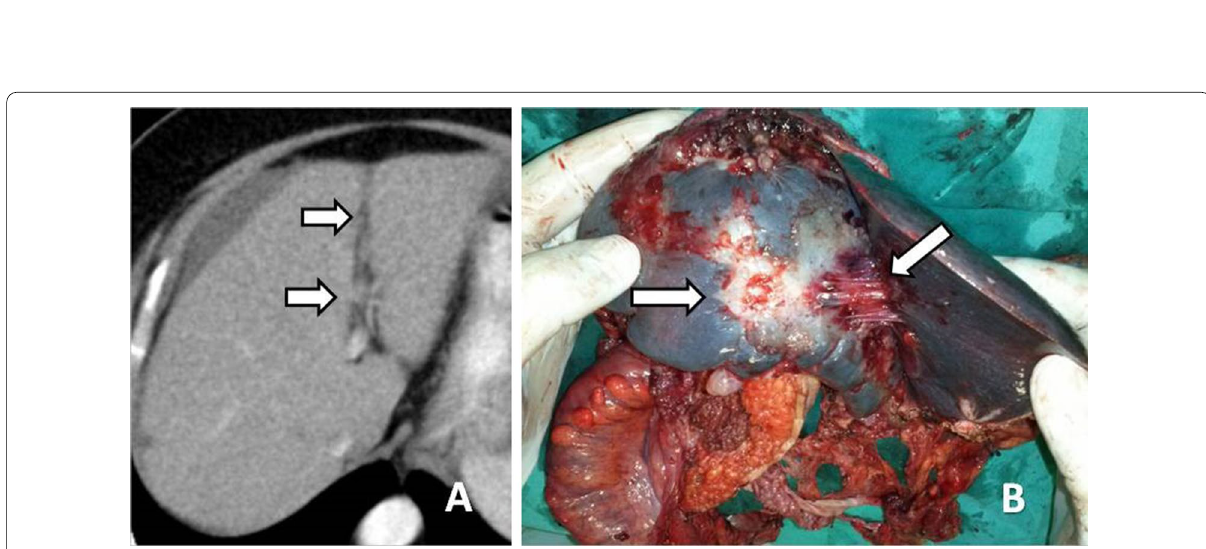
Fig. 6 Patient with ovarian cancer and peritoneal carcinomatosis. a Abnormal tissue, in a “plaque-like” form, is recognized at the area of the falciform ligament (white arrows). Small perihepatic ascites is also seen. b Malignant deposits are demonstrated in the falciform ligament (white